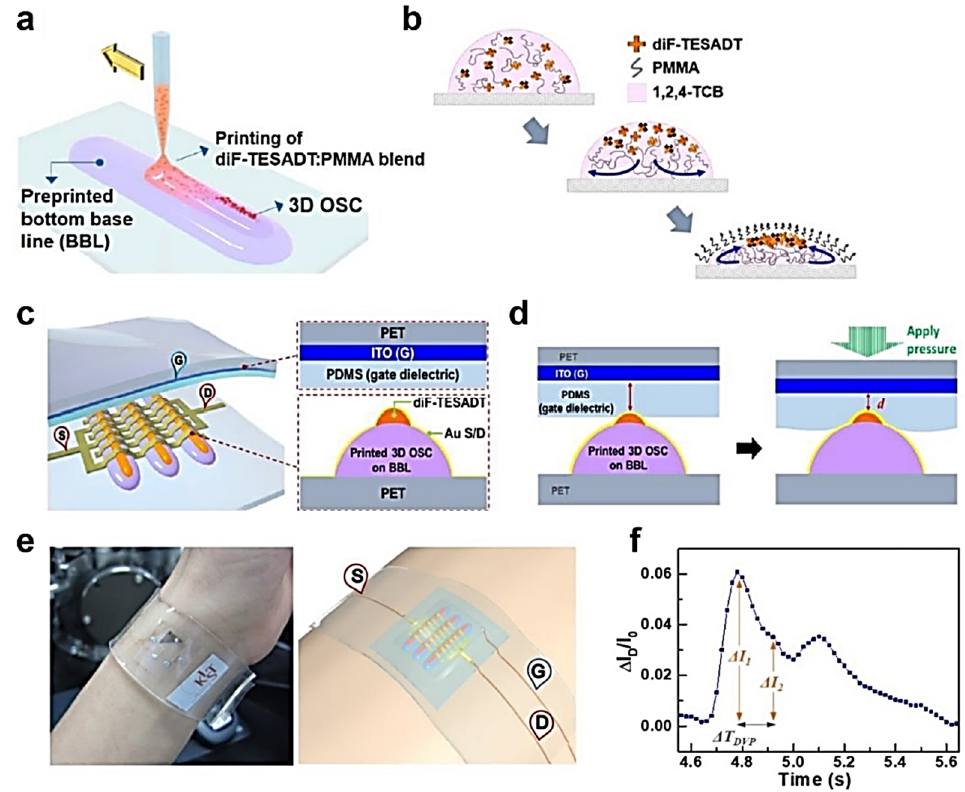
Figure 10. Schematic illustration of ( a ) the fabrication process of the pressure sensor, ( b ) the self- organization of the organic semiconductor, ( c ) the cross-sectional structure of the OFETs, and ( d ) the operation mechanism of OFETs as pressure sensors. ( e ) A photograph and a schematic illustration of the wrist wearing the pressure sensor using a PDMS band. ( f ) Current response to real-time pulse at constant source–drain (−60 V) and source–gate (−40 V) voltages. Three distinguishable peaks were detected. Reprinted from [69], copyright 2017 with permission from the American Chemical Society.